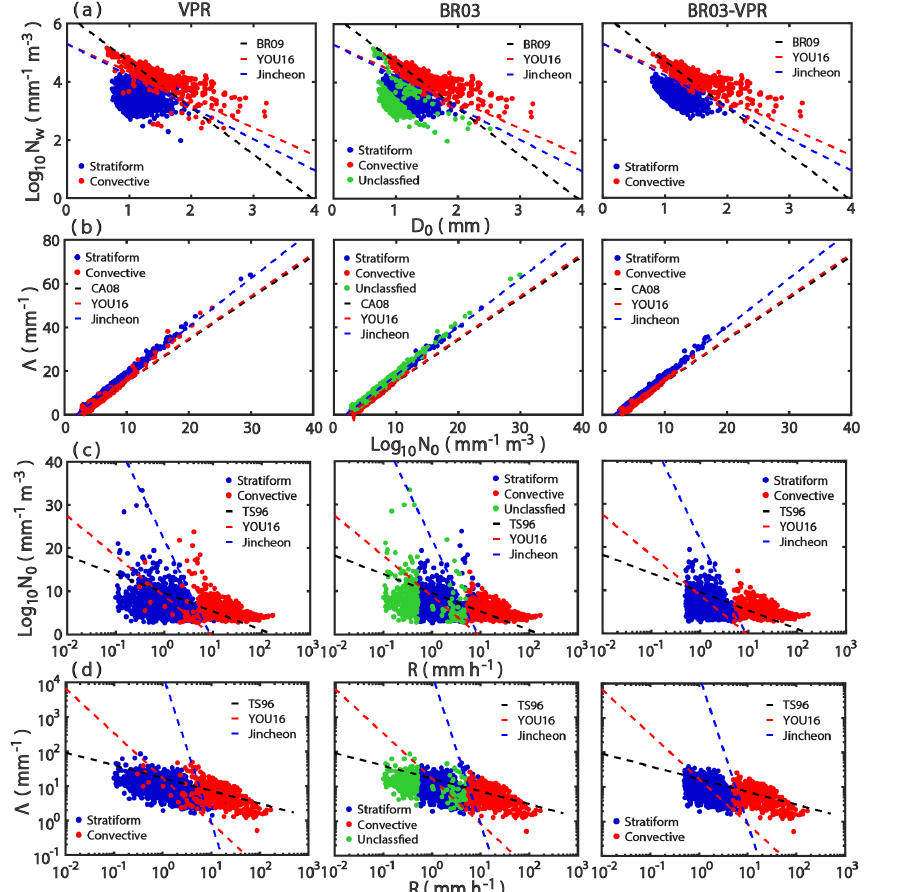
N w (mm − 1 m − 3 ) versus D 0 (mm) with the classification lines from Figure 9. Scatter plots of ( a ) log 10 BR09 (black), YOU16 (red), and derived from the Jincheon data (blue); ( b ) Λ (mm − 1 ) versus log (mm − 1 m − 3 ) with the classification lines from CA08 (black), YOU16 (red), and derived from the N 0 (mm − 1 m − 3 ) versus R (mm h − 1 ) with the classification lines from Jincheon data (blue); ( c ) log 10 TS96 (black), YOU16 (red), and derived from the Jincheon data (blue); and ( d ) Λ (mm − 1 ) versus R (mm h − 1 ) with classification lines from TS96 (black), YOU16 (red), and derived from the Jincheon data (blue) through the VPR (left panel), BR03 (middle panel), and BR03-VPR (right panel) methods. Blue, red, and green dots indicate stratiform, convective, and unclassified rains, respectively. The separator line (blue dashed line) was drawn based on visual examination of the Jincheon